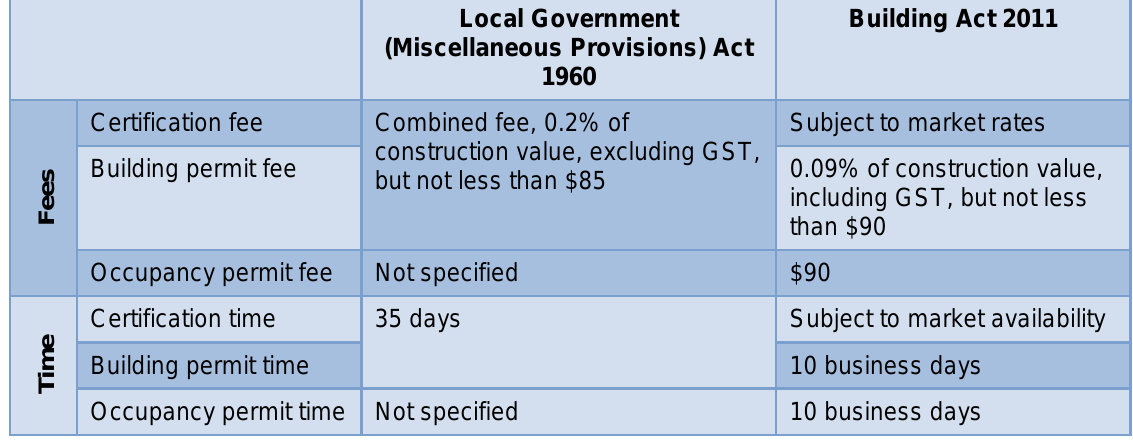
Table 2 Comparison of prescribed fees and timeframes for certification and permits